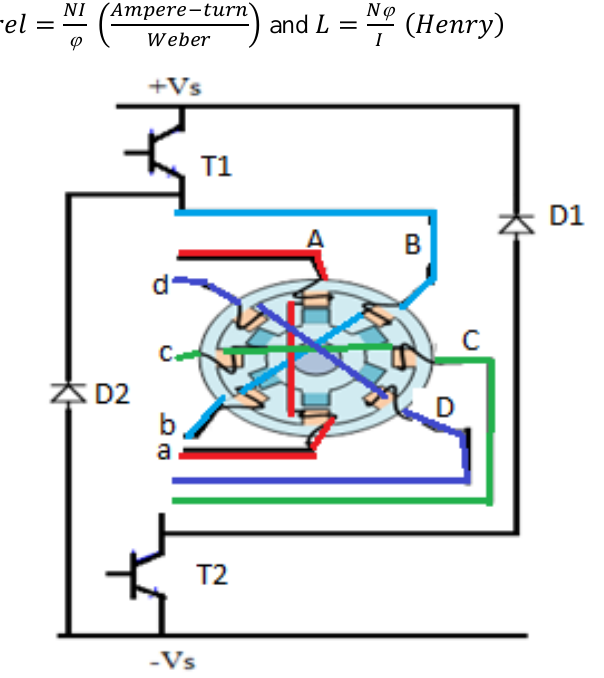
Fig. 1. 8/6 pole switched reluctance machine with